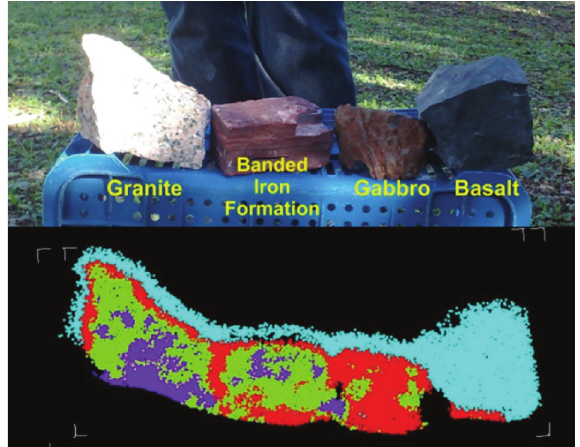
Figure 9: Classified point cloud from the rock samples. The basalt sample (cyan—class 1) is easily recognizable, as the edge effect above all samples, but the other samples need a specific analysis to be identified. The granite is formed by 50% of class 2 (green), 40% of class 3 (purple), and 10% of class 4 (red); the banded iron formation is formed by 70% of class 2, 15% of class 3, and 15% class 4; the gabbro is formed by 85% of class 4 and 15% class